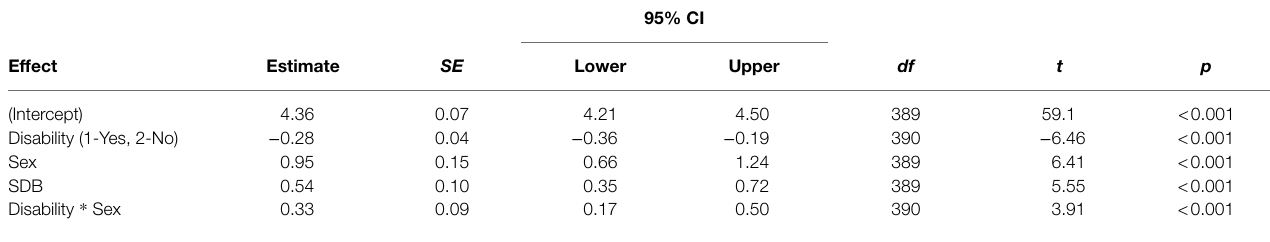
TABLE 2 | Effects for mixed model predicting attractiveness as a function of disability and sex, with SDB as a